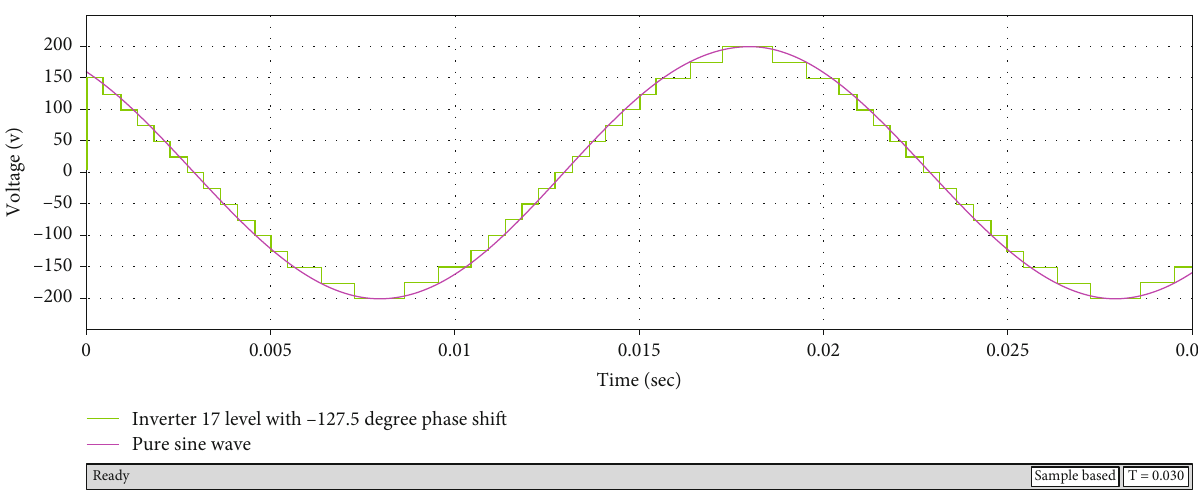
Figure 31: 17-level MLI with t = 0 : 03 for phase b and compared with sine